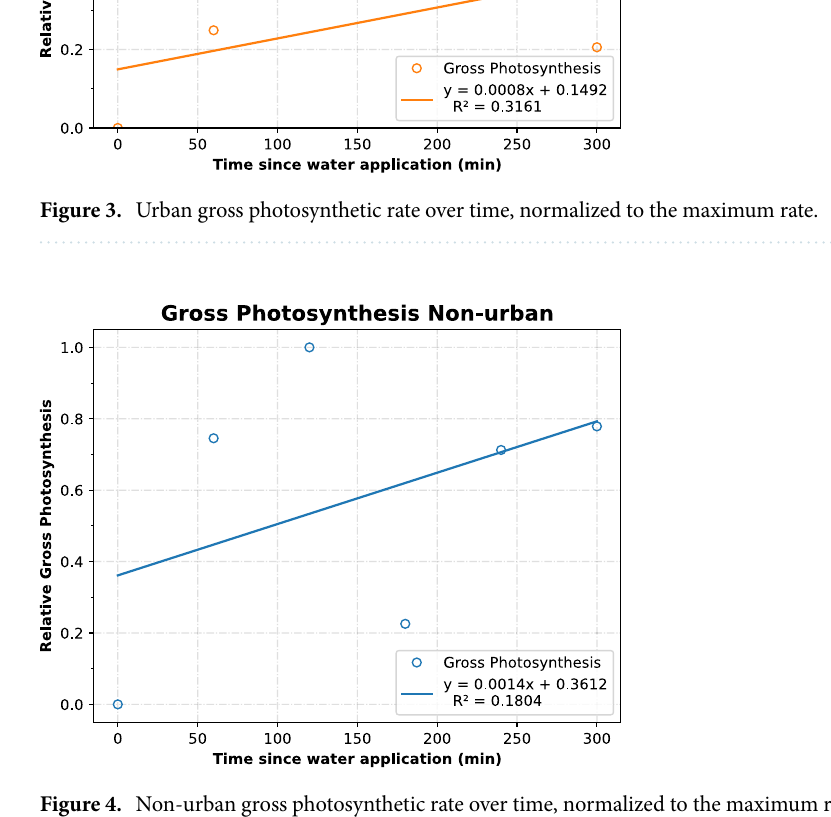
Figure 4. Non-urban gross photosynthetic rate over time, normalized to the maximum